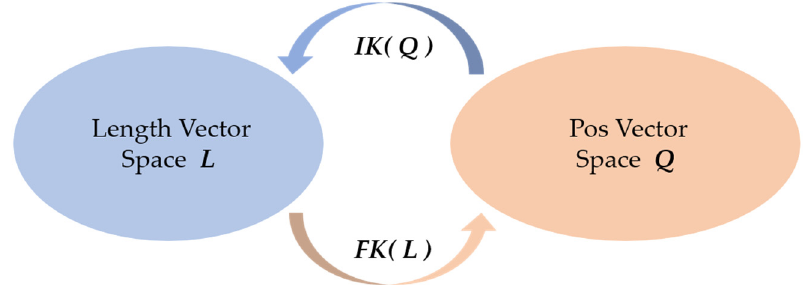
Figure 2. Space Q and L are linked by IK( ) and FK(